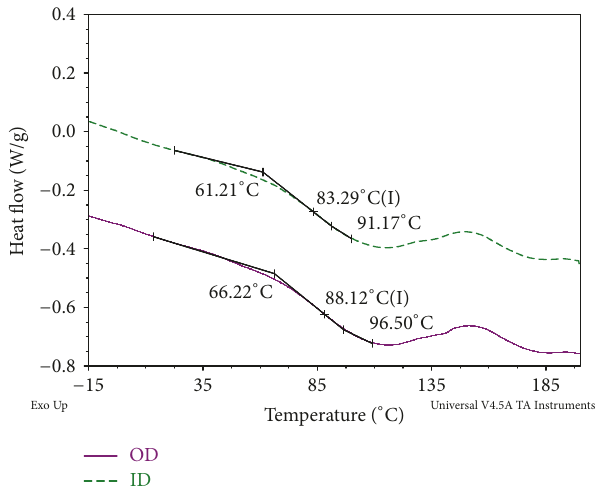
Figure 7: DMTA thermogram is showing the loss modulus of OD and ID films.